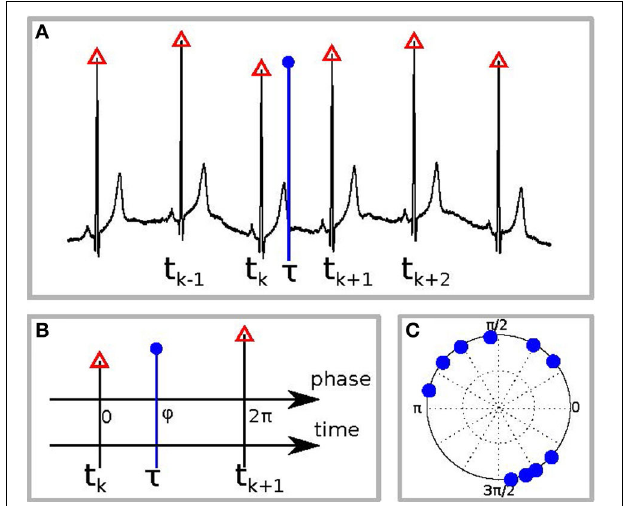
FIGURE 1 | Schematic illustration of the phase calculation. (A) The black curve is the ECG, red triangles denote the R-peaks, and the blue vertical circle denotes the time of the response, e.g., of RB or RE. (B) Defining the phase of R-peak, preceding the response, as 0 and of the following R-peak as 2 π we find the phase of the response ϕ by linear interpolation. (C) An example of the distribution of response phases of RE for 10 different